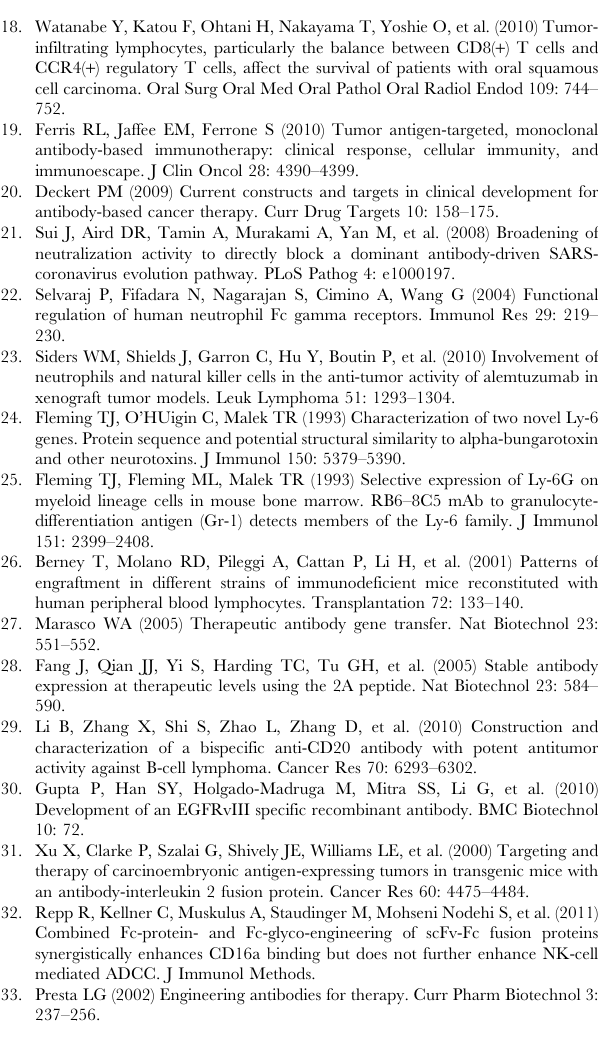
Figure S1 Dose dependent expression of h1567 anti- CCR4 minibody. Nude mice (4 mice per group) were treated one time by tail vein injection with AAV8-h1567 viral vectors